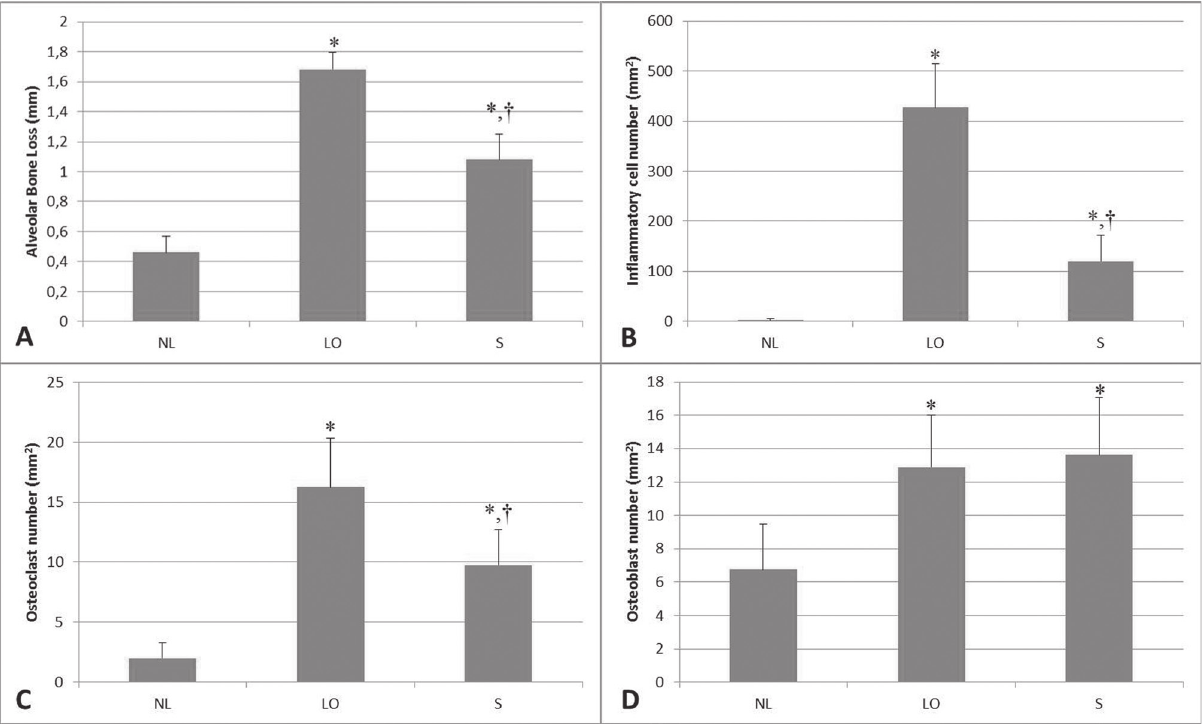
NL=non-ligated; LO=ligature only; S= ligature and treated with sumac Figure 1- A- Mean alveolar bone loss in groups; B- The number of inflammatory infiltrate (mm 2 ) in the study groups; C- The number of osteoclasts (mm 2 ) in the study groups; D- The number of osteoblasts (mm 2 ) in the study groups. *Significant difference compared to NL group. †Significant difference compared to LO